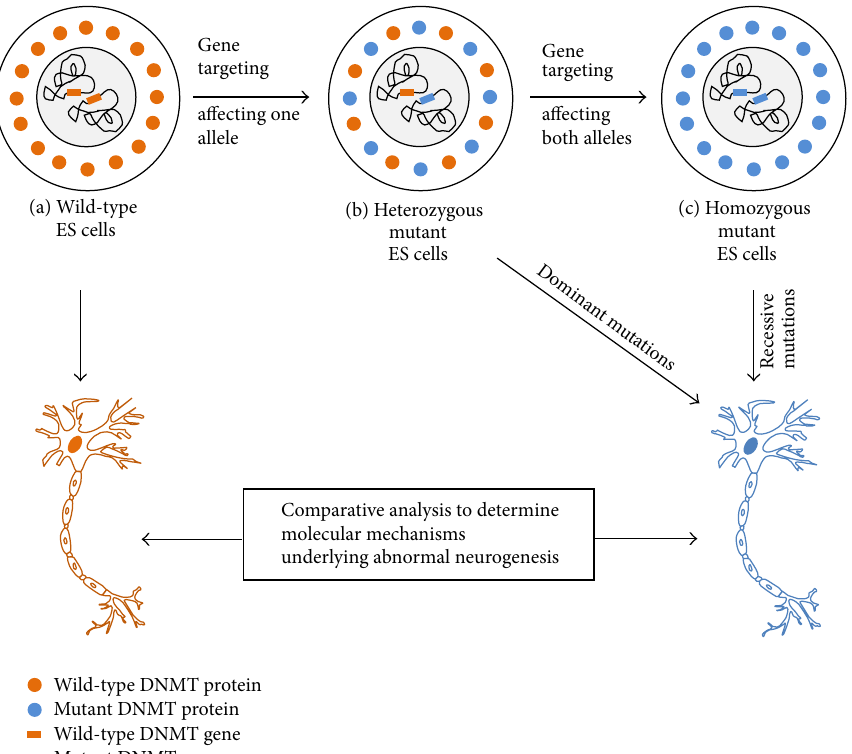
Figure 2: Schematic representation generation of embryonic stem cell-based models for studying the role of DNMT dysregulation on development of abnormal neuronal phenotypes. Desired mutations can be selected on the basis of literature evidence of mutations in DNMTs that are associated with neuropsychiatric disorders. Both alleles of DNMTs ( de novo and maintenance) can be targeted to introduce desired mutations in the wild-type ES cells. First round of targeting results in heterozygotes which can then be used for a second round of targeting that results in homozygotes. Following gene targeting, homozygous ESCs (for recessive mutations) or heterozygous ESCs (for dominant mutations) can be differentiated into neurons. The resultant neurons can be used for detailed physiological and molecular-genetic studies to identify the molecular basis for abnormal neuronal